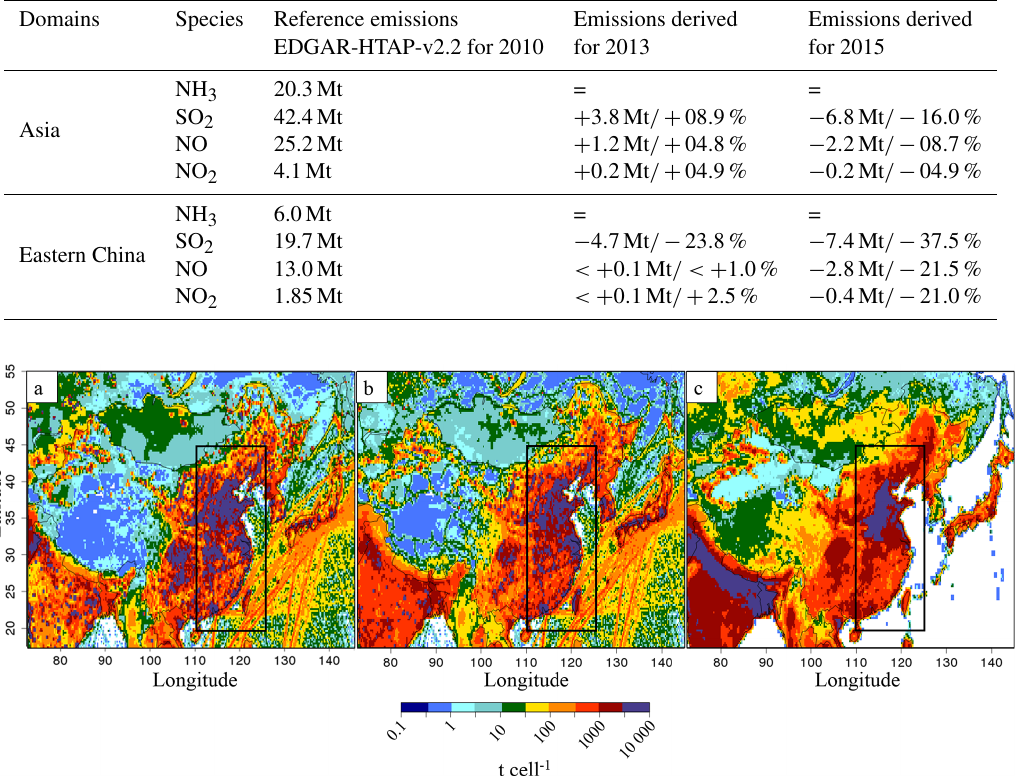
Table 1. Annual budgets of the EDGAR-HTAP-v2.2 inventory and of emissions corrected from the OMI instrument (this work), for SO 2 , NO and NO 2 , over Asia and over eastern China (in Mt). The Asian domain corresponds to our full domain (72 ◦ 30 (cid:48) –145 ◦ E, 17 ◦ 30 (cid:48) –55 ◦ N),